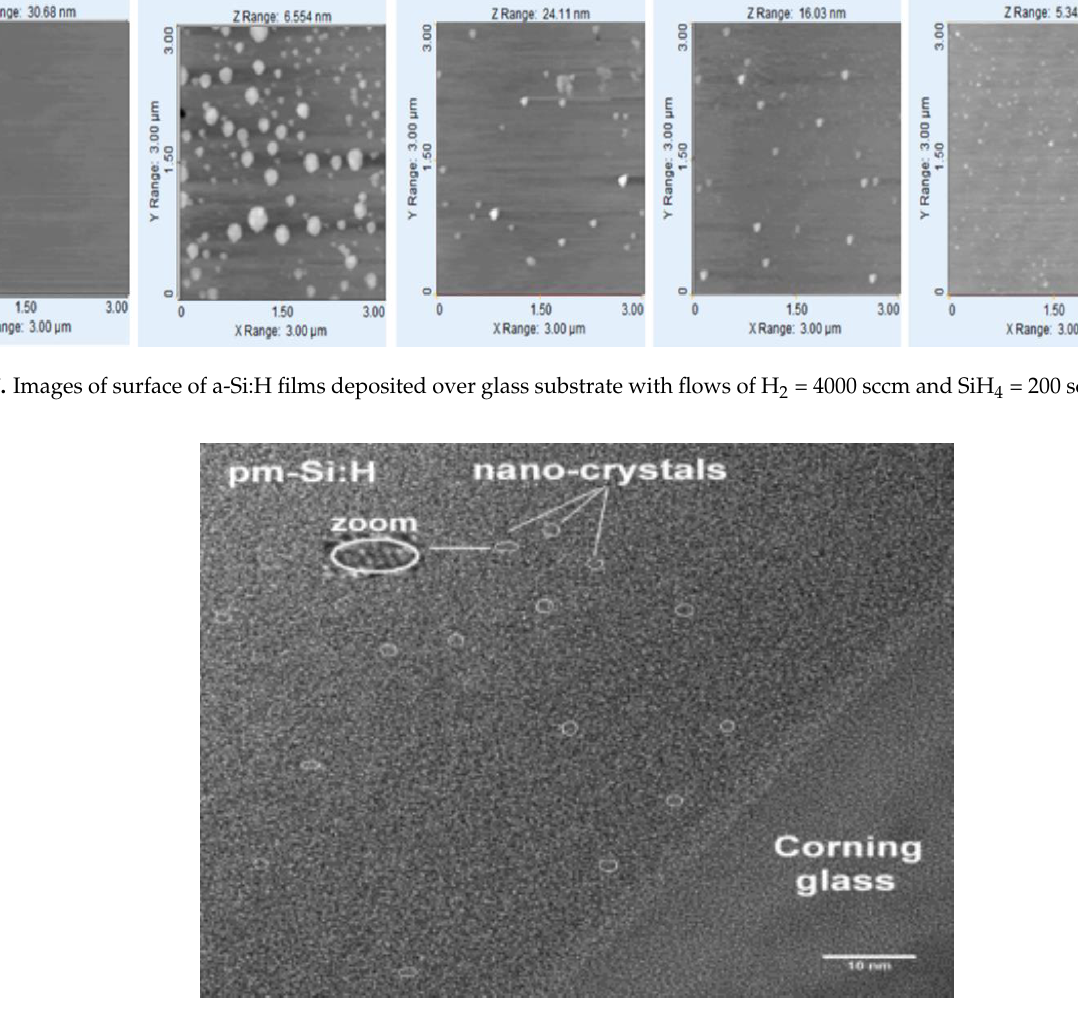
Figure 8. SEM photo of the sample at 2000 mTorr, where nano-crystals appear.